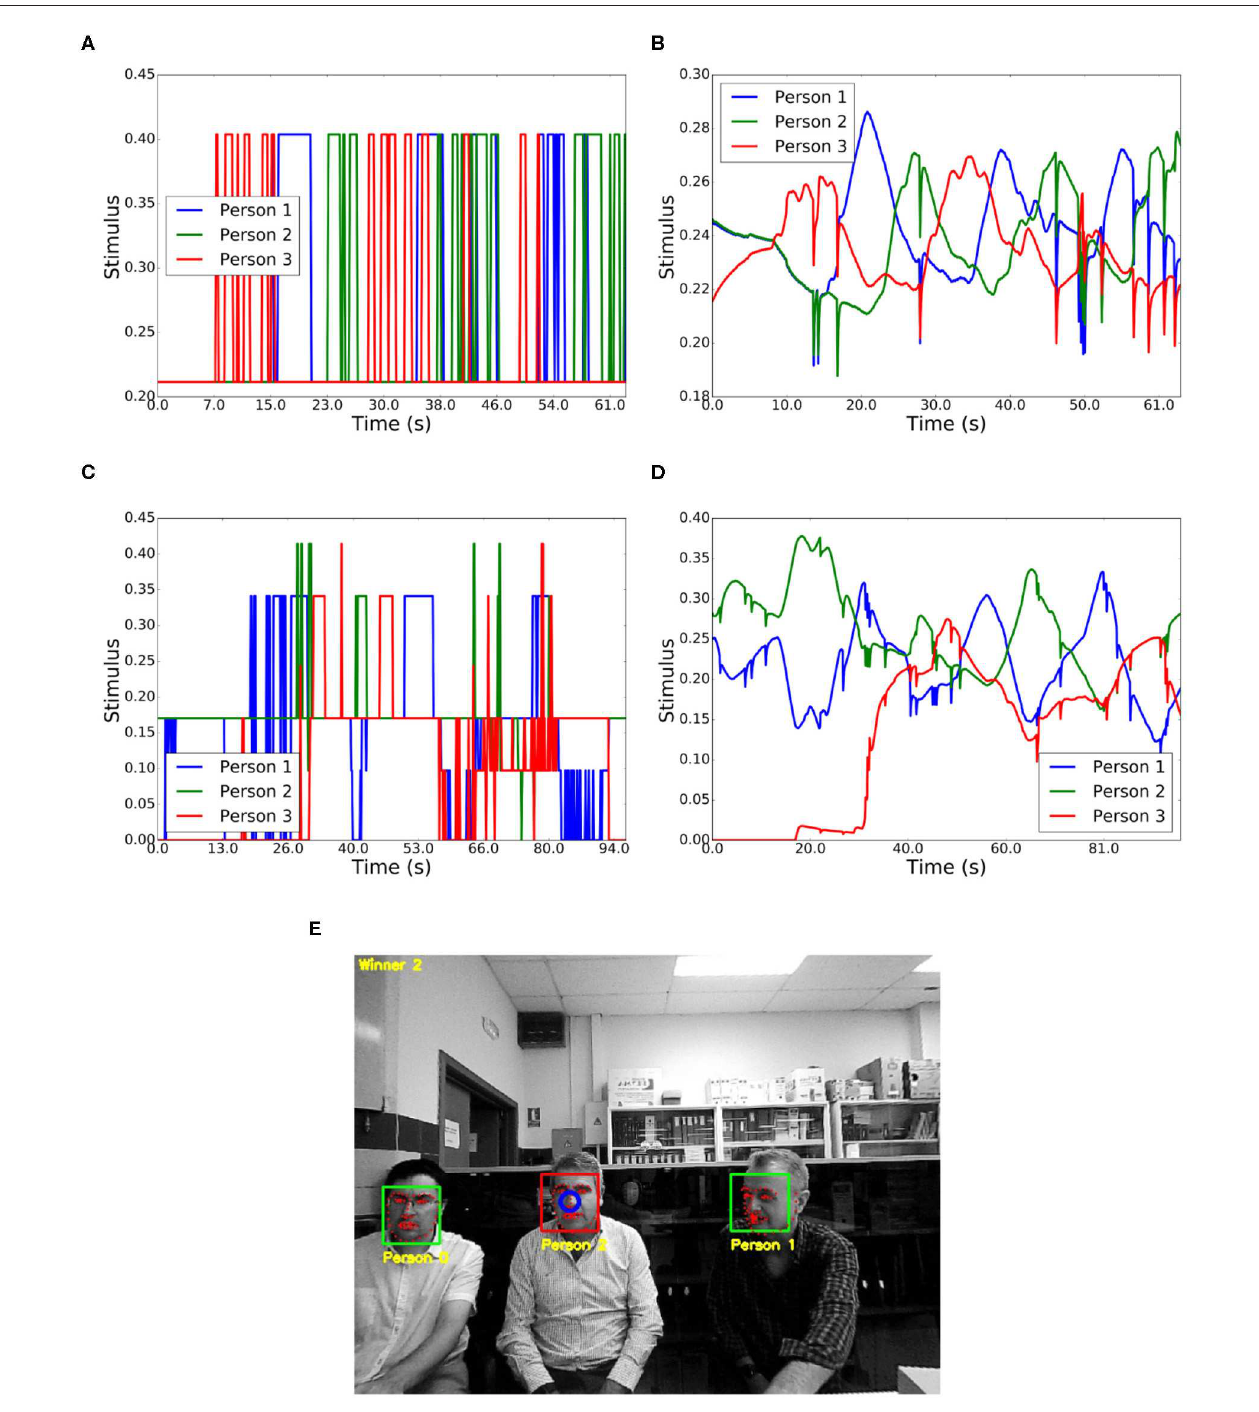
FIGURE 12 | Interaction between three people. (A) Input stimuli in a conversation. (B) Output stimuli in a conversation. (C) Input stimuli with different actions. (D) Output stimuli with different actions. (E) Result of the visualization node showing the winner.